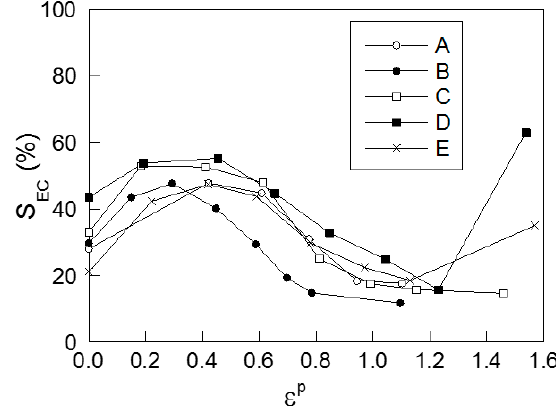
Figure 15. Evolution of the area of the external crown with the drawing degree.